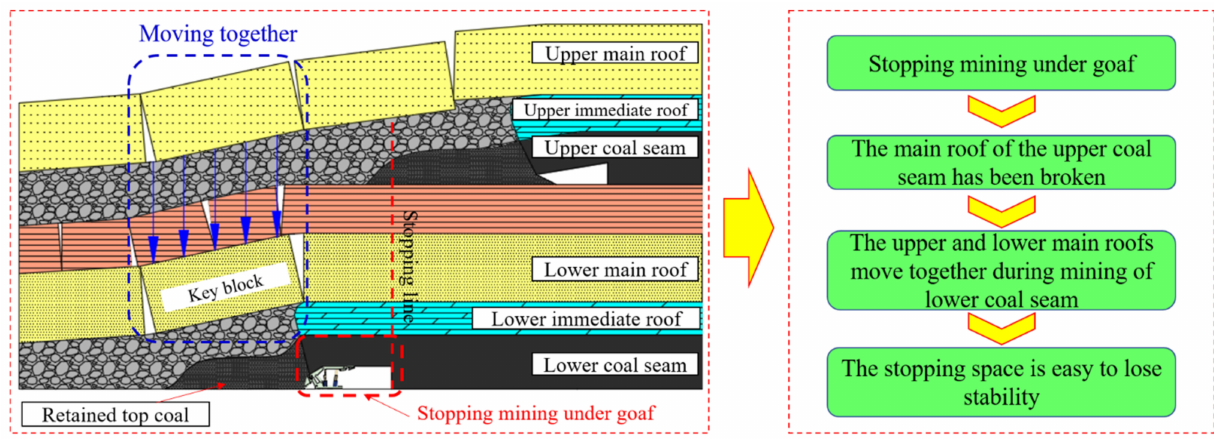
Figure 2. Schematic diagram of stopping mining under